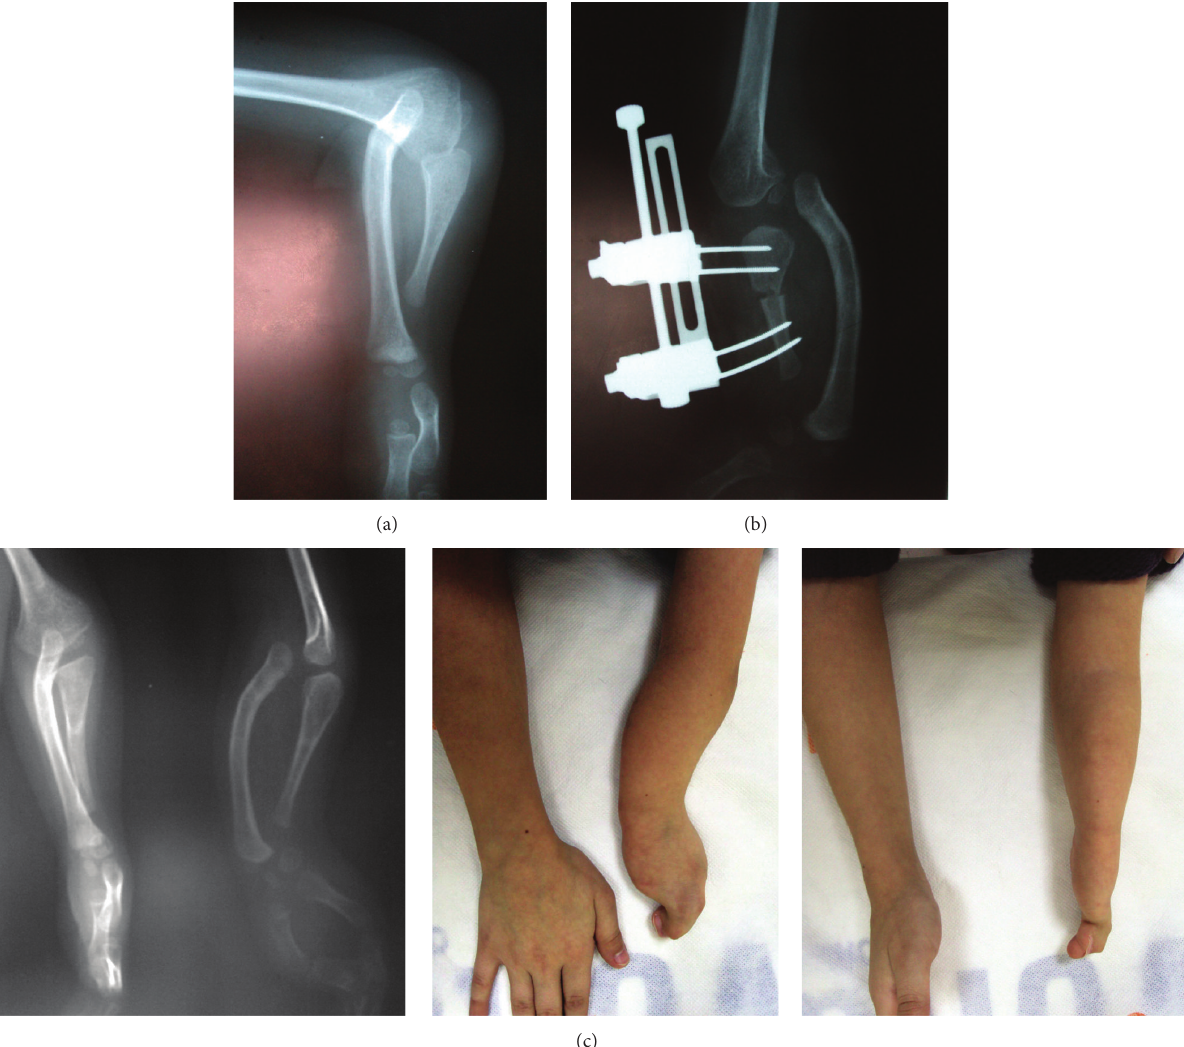
Figure 2: The preoperative, intraoperative, and postoperative images of the second case. (a) Preoperative and (b) intraoperative (c) images of patients after implants were